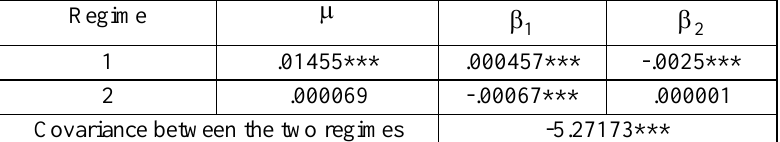
Table 10: results of estimating 2-regime model coefficients in terms of liquidity and risk Regime